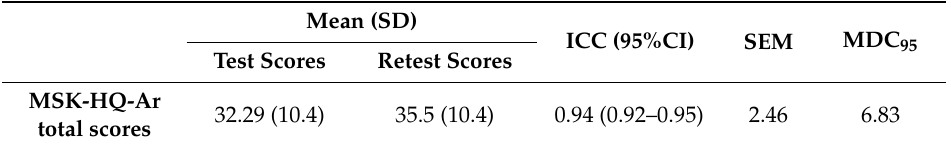
Table 5. Test-retest reliability of the